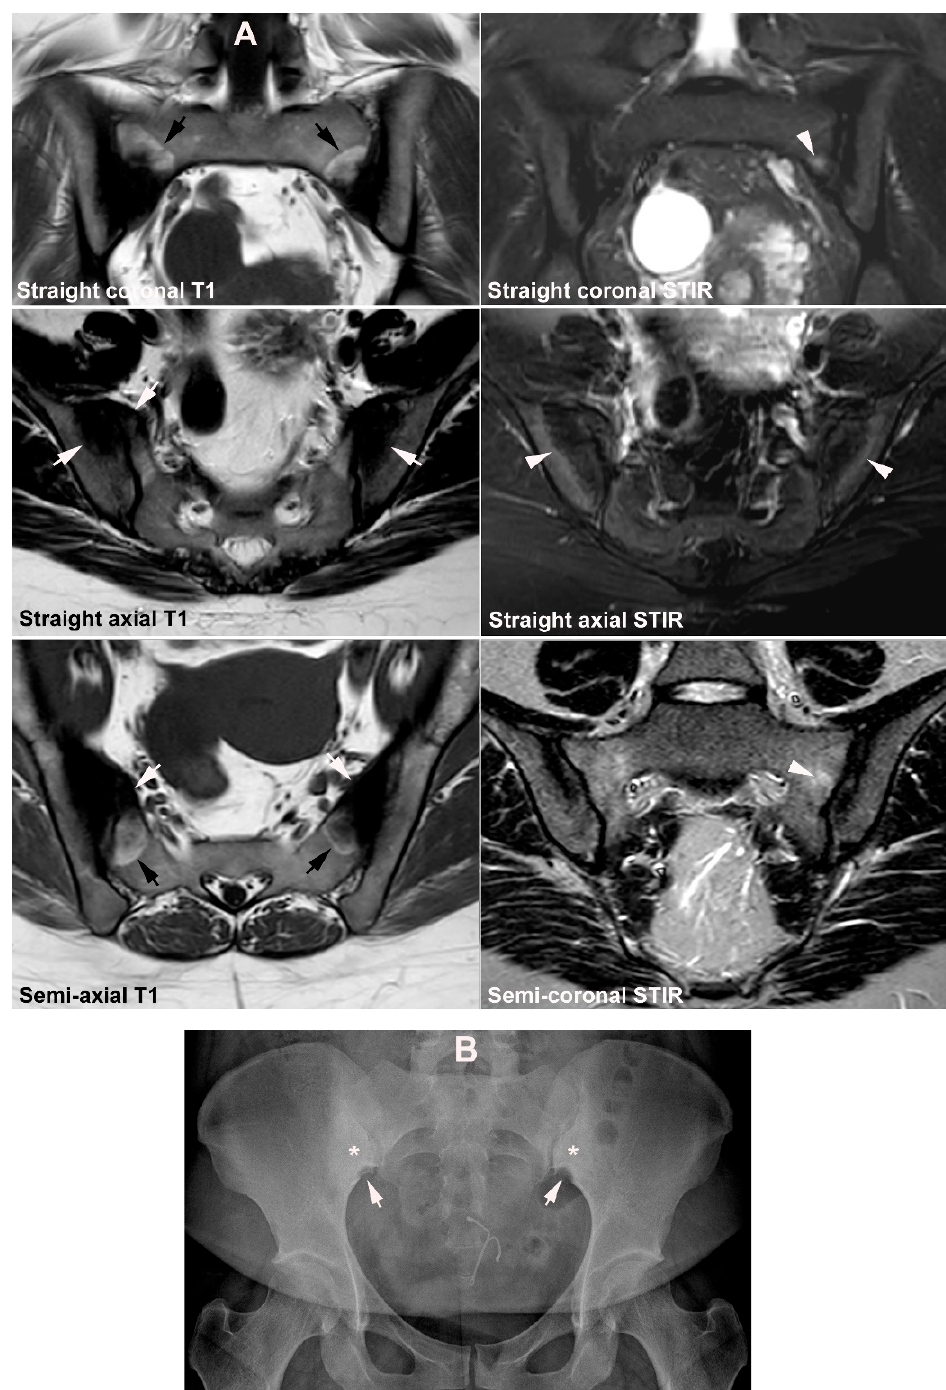
Figure 15. Osteitis condensans ilii (OCI). ( A ) MRI of a 32-year-old woman with three preceding pregnancies, straight coronal and axial T1 and STIR images (two upper image rows) in addition to semi-axial T1 and semi-coronal STIR of the SIJ. There is manifest bilateral iliac sclerosis in addition to sclerosis anteriorly in the sacrum (white arrows) with surrounding pronounced fat deposition anteriorly in the sacrum (black arrows on T1). There is a brim of BME peripheral to the iliac sclerosis in addition to anteriorly in the sacrum on the left side (arrowheads). ( B ) Pelvic radiograph shows typical OCI changes in the form of bilateral iliac sclerosis (asterisks) in addition to para-glenoidal sulci (arrows) consistent with strain-related changes.